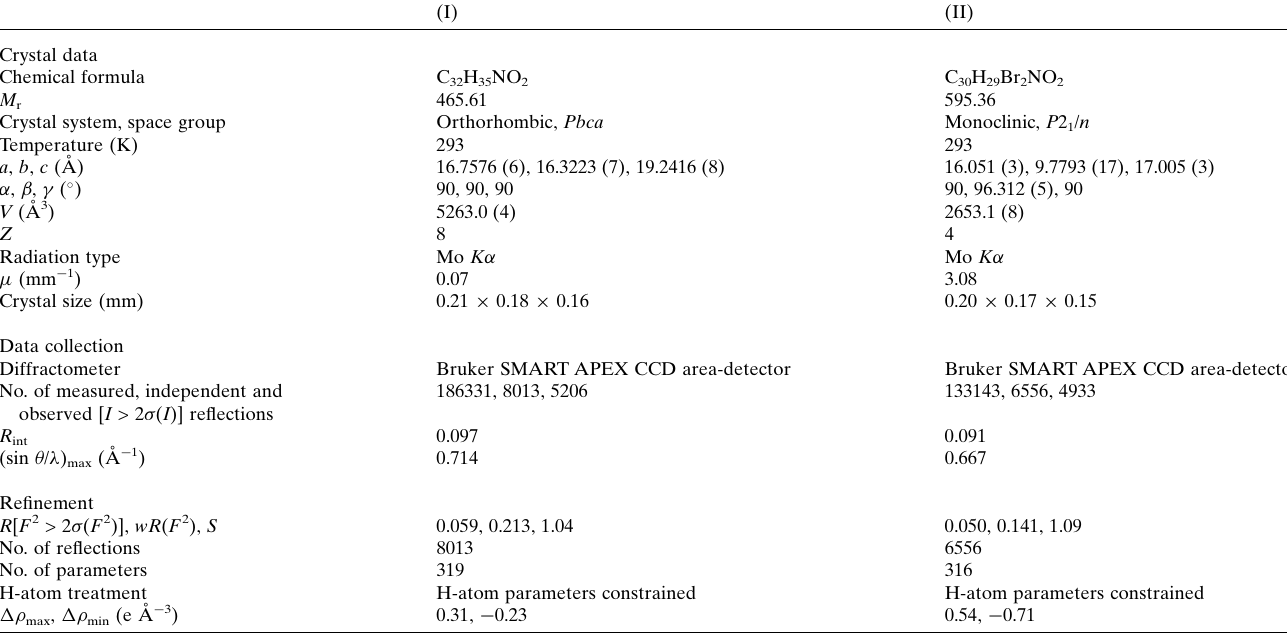
Table 3 Experimental details.